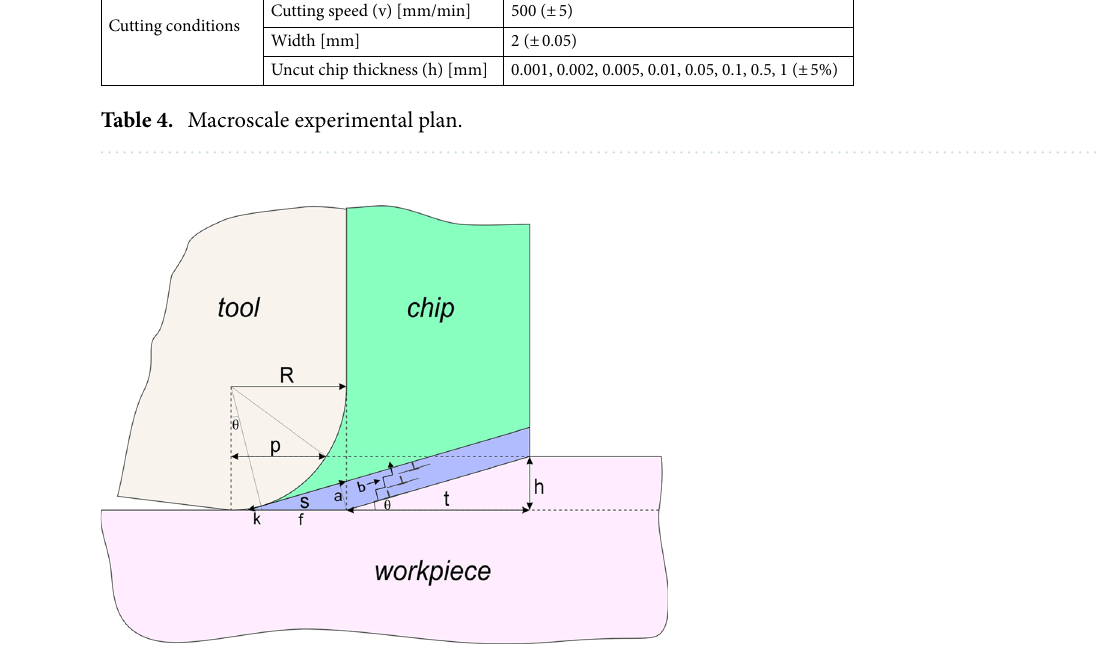
Figure 11. Sketch of dimensions defining the cutting geometry used in the calculations of K fric and K PSZ